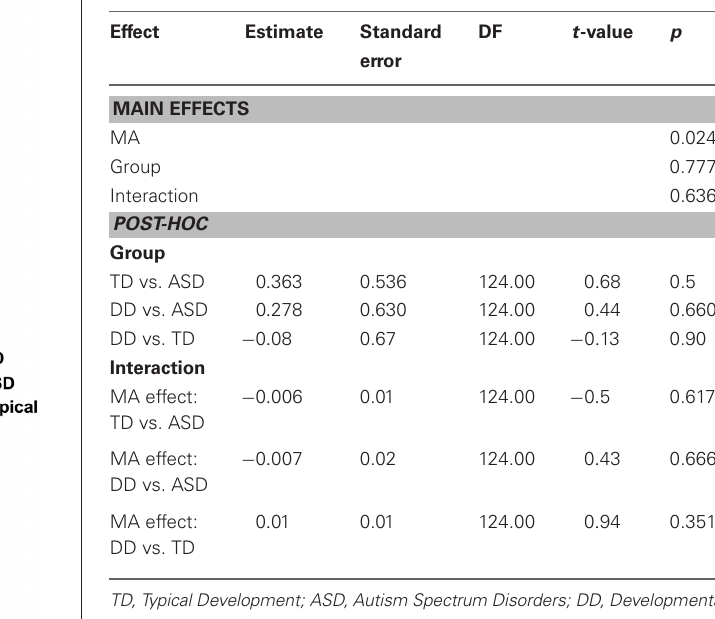
Table 4 | Grip to load force onset latency and mental age (MA).